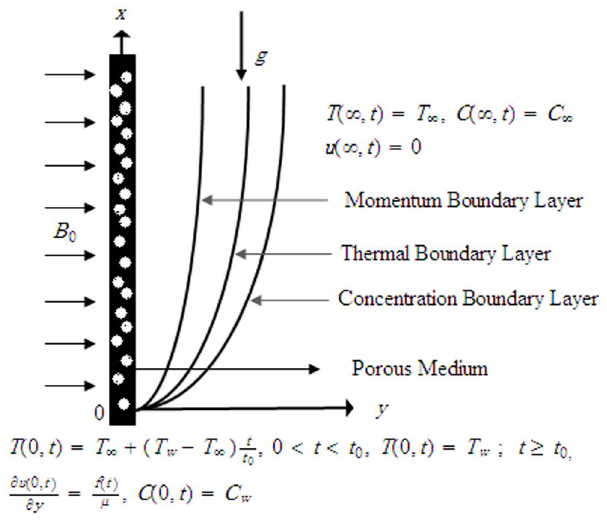
Figure 1. Physical configuration of the problem.